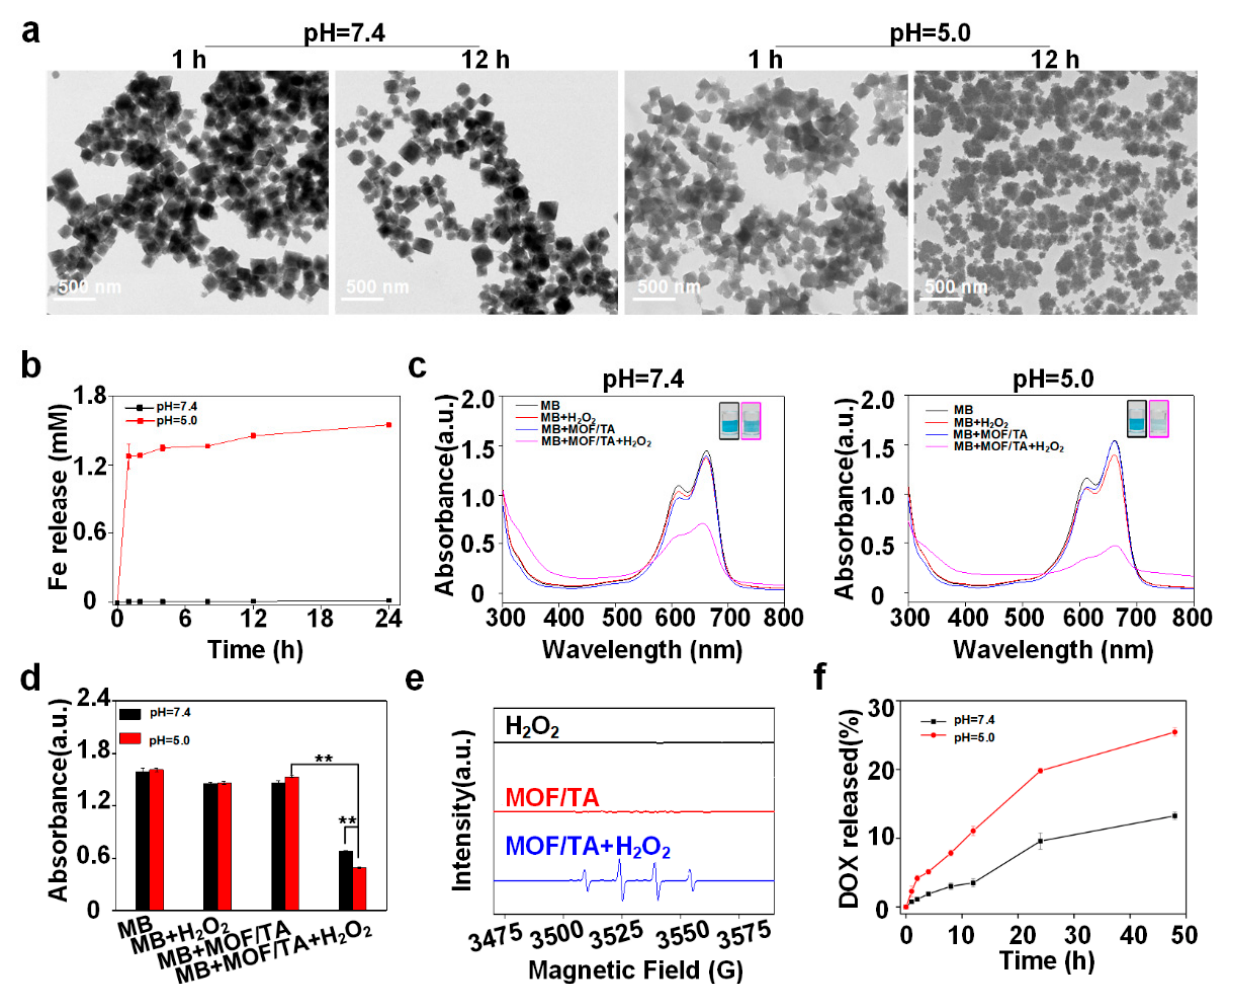
Figure 2. pH-responsive property and •OH generation of MOF/TA: ( a ) pH-responsive biodegraded property of MOF/TA; ( b ) iron release behavior of MOF/TA; ( c ) MB absorbance spectrum under acidic and neutral conditions after the different treatments; ( d ) MB absorbance at 665 nm under acidic and neutral conditions after different treatments; ( e ) ESR spectrum of different samples; ( f ) DOX release behavior of MTD. Data are represented as the arithmetic mean ± SD, and one-way ANOVA followed by Dunnett’s test were performed for statistical analysis (** p < 0.01).